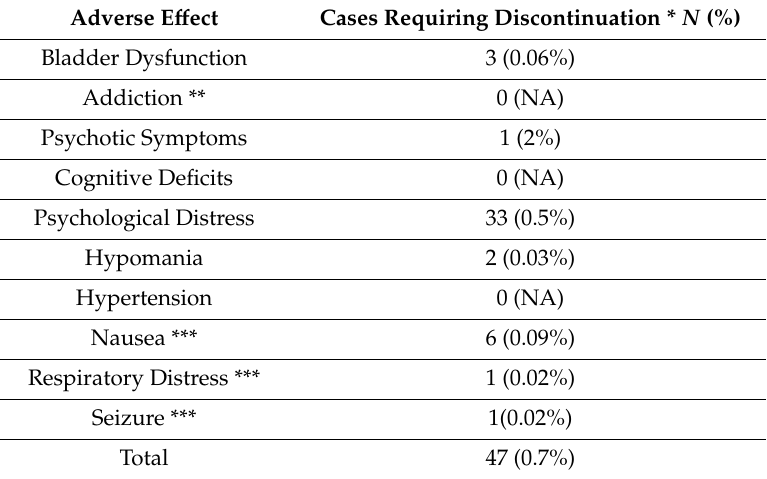
Table 2. Serious adverse e ff ects reported by